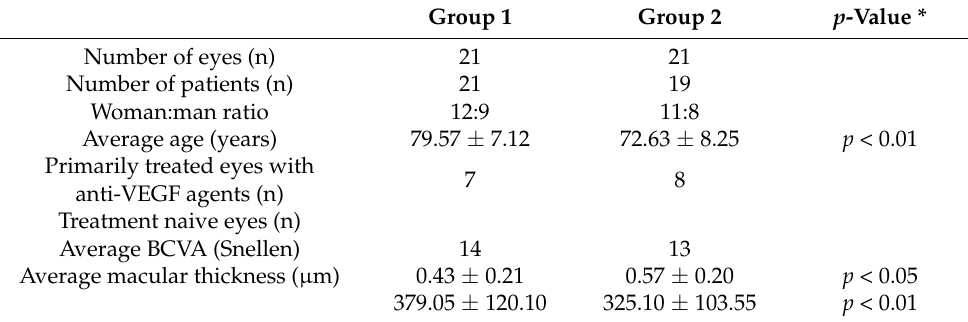
Table 1. Demographic data and basic parameters describing examined